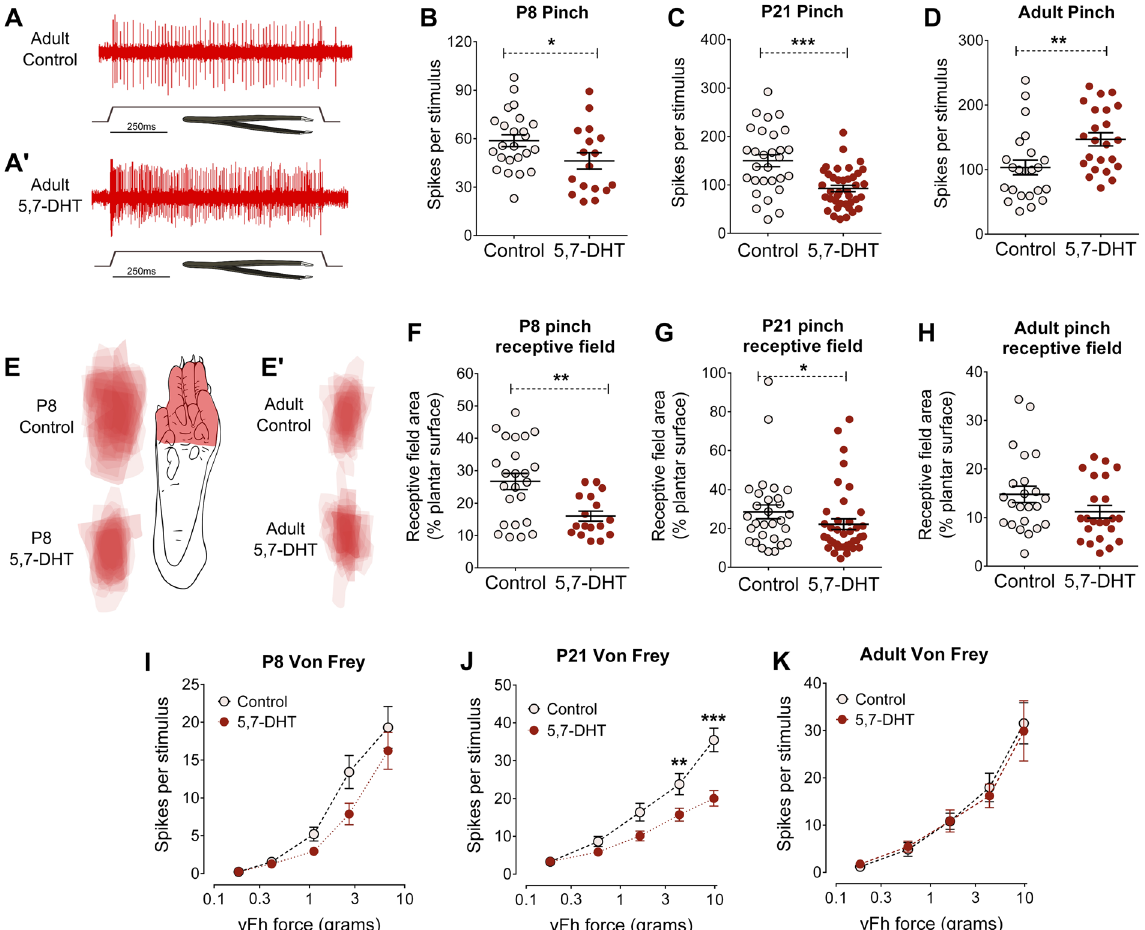
Figure 2. Serotonergic modulation of noxious stimulus-evoked dorsal horn neuron activity is age-dependent. Pinch-evoked activity of dorsal horn WDR neurons was recorded at P8 and P21 and in adult rats. A typical recording of pinch-evoked dorsal horn neuron firing activity in adult control ( A ) and (A ′ ) 5,7- DHT-treated rats. Pinch-evoked firing activity was significantly lower in 5,7-DHT-treated animals compared to controls at P8 ( B ) and P21 ( C ), but higher in adult rats ( D ). Pinch receptive fields were mapped on to a standardised paw template to create heat maps for control and 5,7-DHT-treated rats in P8 ( E ) and adult rats (E ′ ). A typical dorsal horn neuron pinch receptive field from a P8 control rat is shown. Pinch receptive field area was significantly smaller in 5,7-DHT-treated compared to control at P8 ( F ) and P21 ( G ), but not in adult rats ( H ). Dorsal horn neuron responses to increasing forces of von Frey hairs (vFh) was lower in 5,7-DHT-treated compared to controls at P21 ( J ), but not in P8 ( I ), or adult rats ( K ). Bars indicate mean ± SEM. * , ** , *** P < 0.05, 0.01,